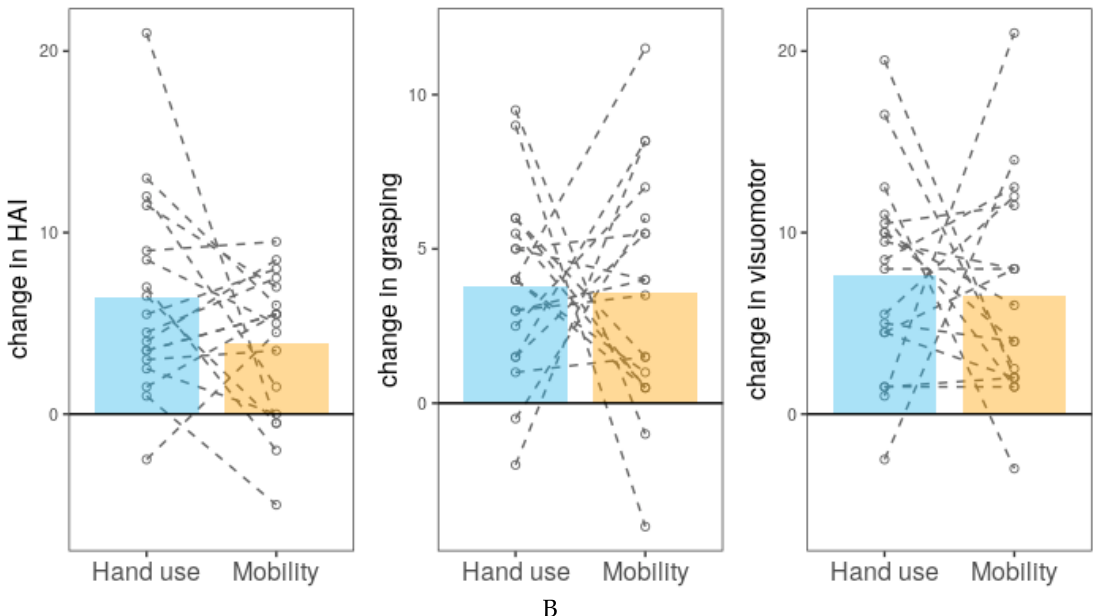
Figure 3. Average of group and individual changes (for both periods) in outcomes for hand use and mobility training. The changes in scores is calculated as a di ff erence between scores after and before a training period. The bars represent averages across all subjects. The dots represent results for each individual averaged across 2 periods of hand training and 2 periods of mobility training connected with dashed lines. ( A ) Changes in gross-motor function. Left: Changes in the GMFM-66. Middle: Changes in the score on the stationary subscale of the PDMS-2. Right: Changes in the score on the locomotor subscale of the PDMS-2. ( B ) Changes in fine-motor function. Left: Changes in the HAI score. Middle: Changes in the score on the grasping subscale of the PDMS-2. Right: Changes in the score on the visuomotor subscale of the PDMS-2. The range of the di ff erent scales is described in the Methods section.